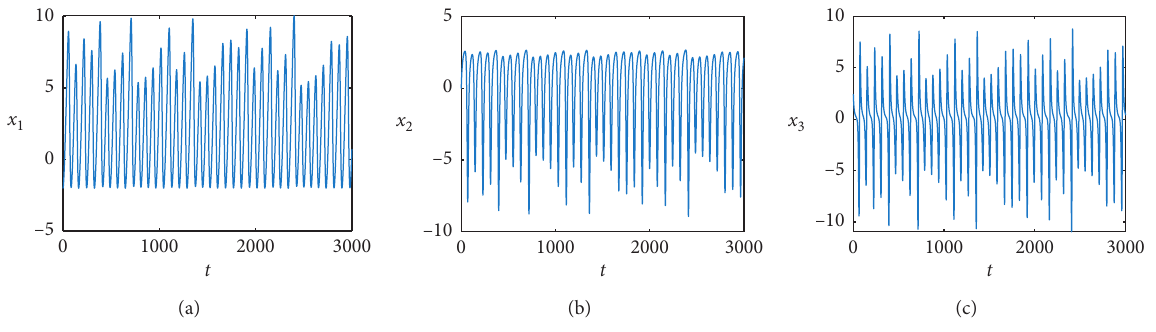
Figure 1: Chaotic attractor of the 3D jerk system (1) and projection in x x